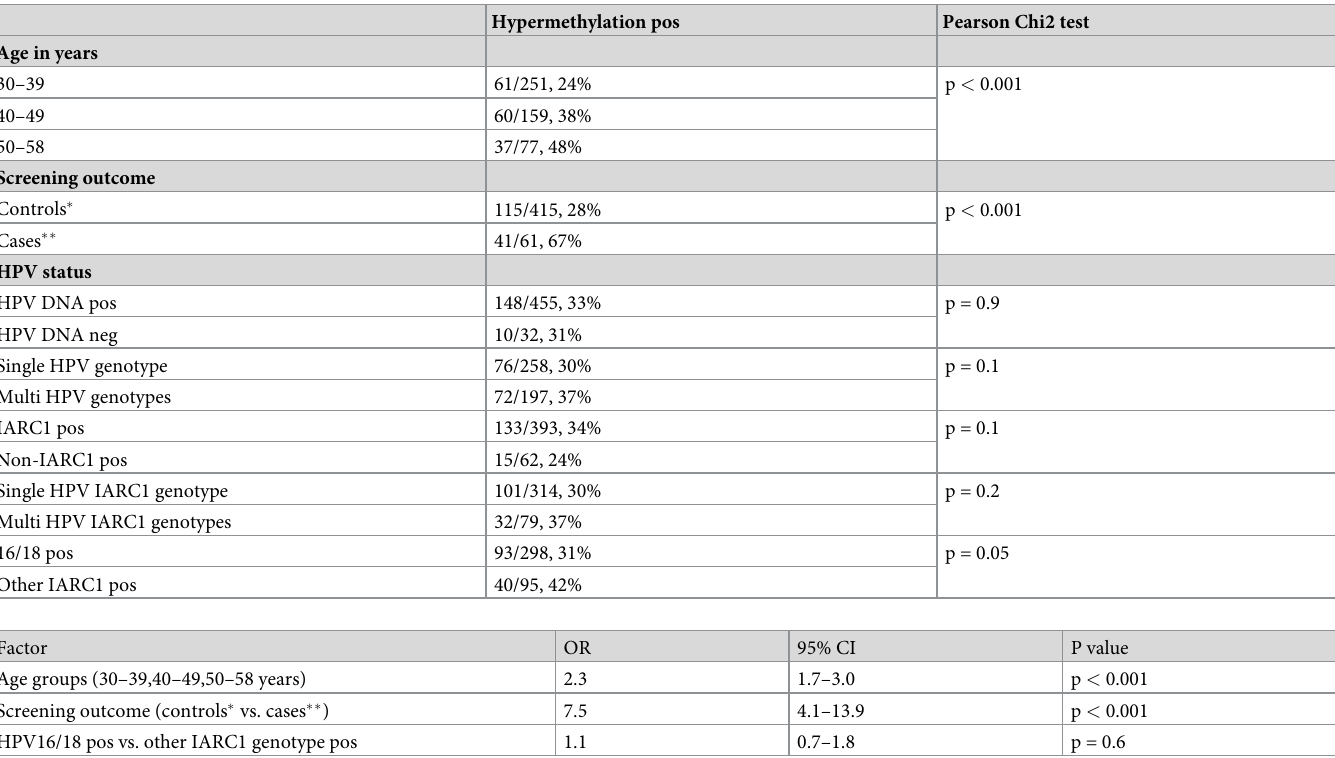
Table 2. A. Results from FAM19A4/miR-124-2 hypermethylation analysis. Presented in comparison between groups of differing age, screening outcome, and HPV sta- tus. The HPV groups presented were positive vs. negative genotyping test, single vs. multiple genotypes within positive samples, positive for IARC1 genotype vs. positive for other non-IARC1 genotype, single vs. multiple IARC1 genotype within IARC1 positive samples, and HPV16/18 positive vs. positive for other IARC1 genotype. B. Mul- tivariate analysis. Binary logistic regression analysis of predictive factors for hypermethylation positivity in the FAM19A4 and hsa-miR124-2